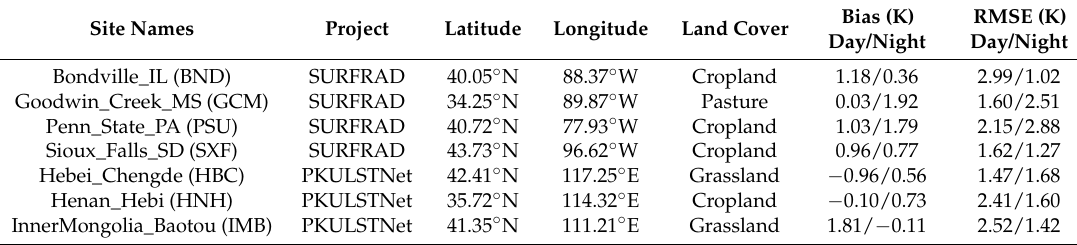
Table 4. Detailed information and validation results of each ground